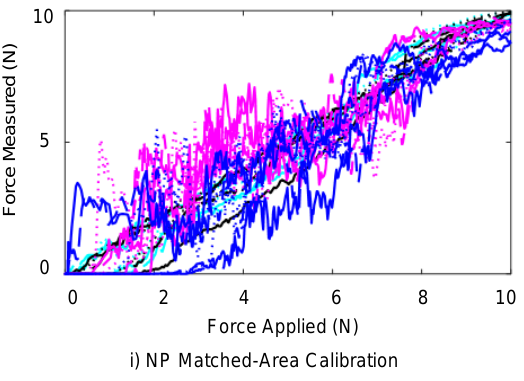
i) NP Matched-Area Calibration ii) YP Matched-Area Calibration